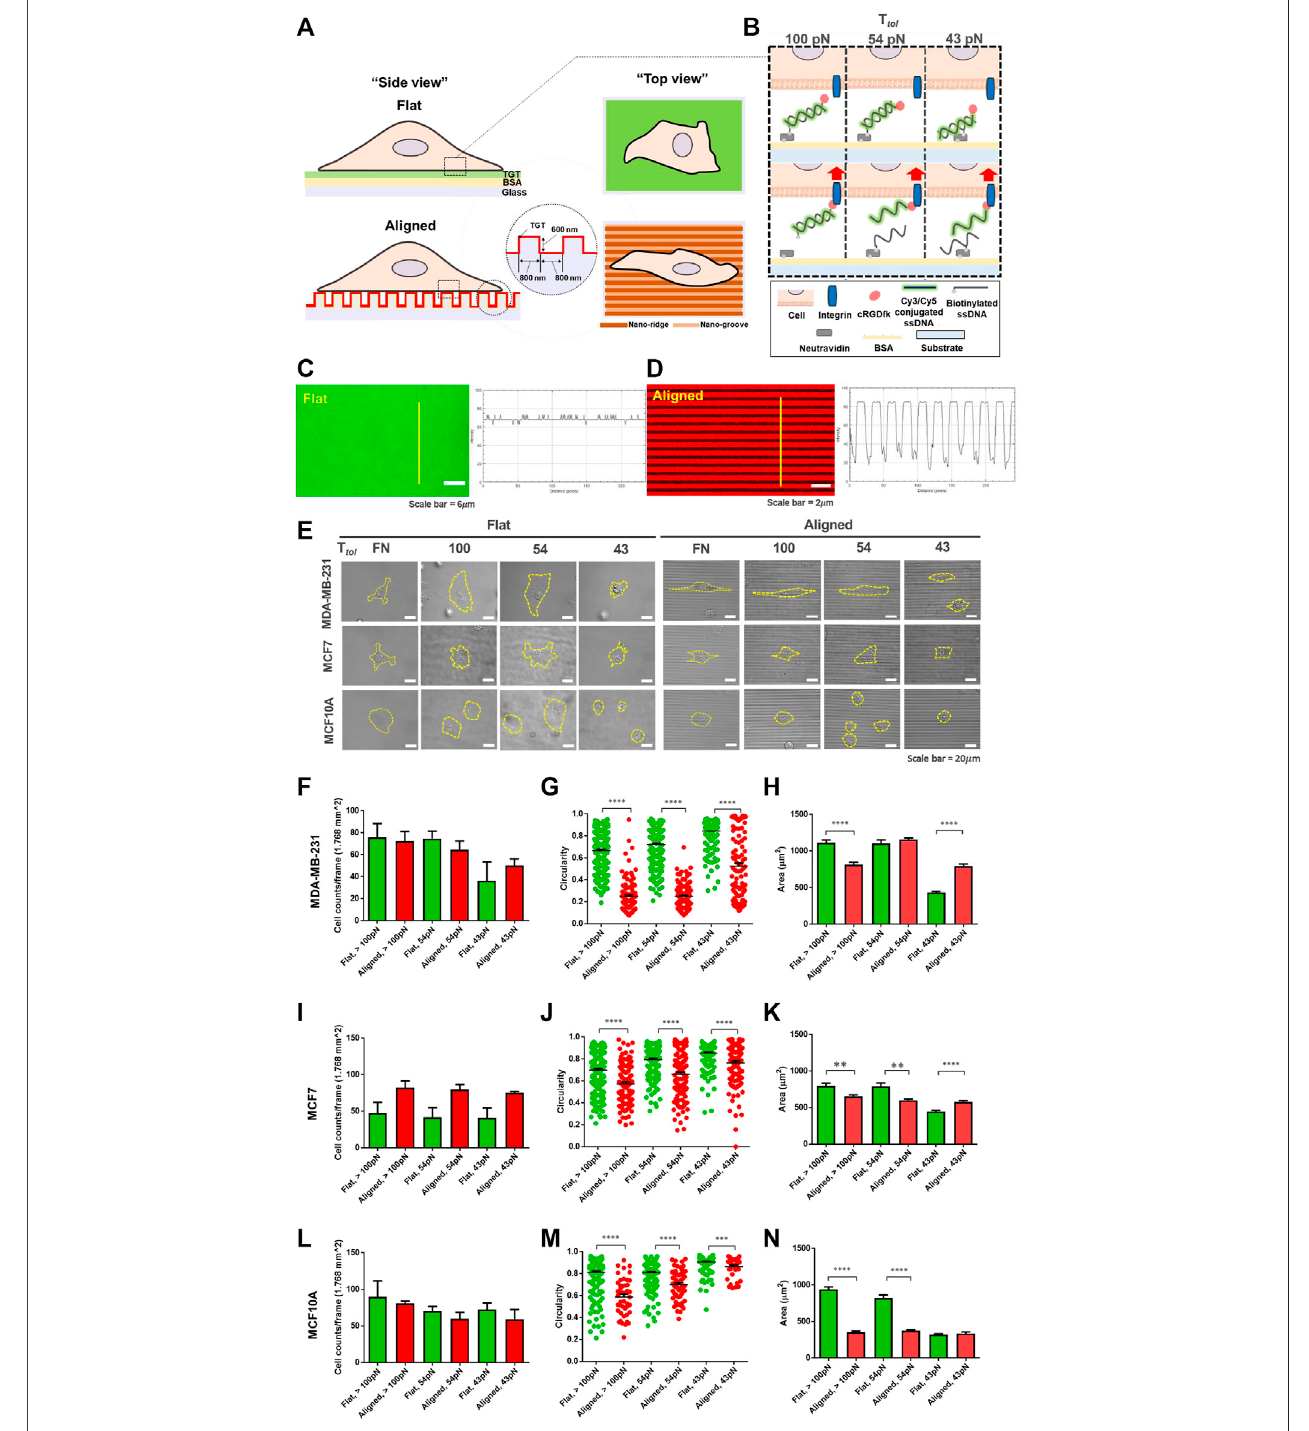
FIGURE 1 | Development of the topo-TGT assay: tension gauge tether (TGT)-coated nanosurface and cell adhesion on the nanosurface. (A) Schematic representation of cell adhesion on the single molecule integrin tension probe, tension gauge tether (TGT), and coated surfaces ( fl at and anisotropic nanopatterns). (B) TGTconstructs and their working principle. ThreedifferentTGT constructs with T tol of43,54, and 100 pN wereprepared. (C,D) Veri fi cation ofthe TGTcoating on each surface. (C) Cy3-conjugated TGT molecules were immobilized on the fl at surface via biotin-neutravidin bonds, and the fl uorescentintensity pro fi le was plotted. (D) ImageofCy5-conjugatedTGT-coatednanosurface.Theintensitypro fi leindicatesTGT-coatingonthealignednanopatterns. (E) Representativeimagesofadherentcells on each surface (incubation time, t = 2 h). Three different human breast epithelial cell lines were used in this study: two human breast cancer cell lines, MDA-MB-231